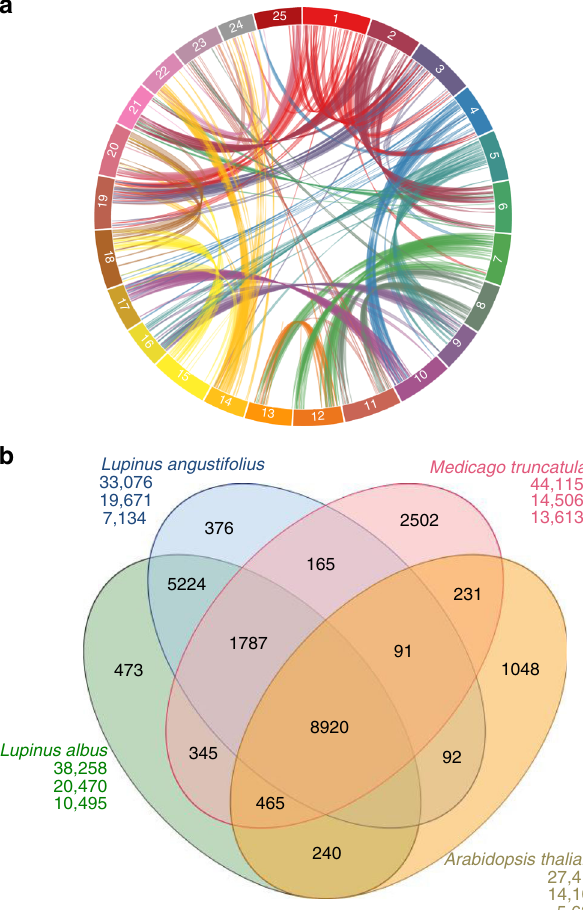
Fig. 4 Lupin genome intragenomic duplications and genomic synteny. a Syntenic regions inside white lupin genome. The colored lines link colinearity blocks that represent syntenic regions that are bigger than 50 kb. b OrthoMCL clustering of white lupin genes with those of L. angustifolius , M. truncatula and A. thaliana . Numbers in the sections of the diagram indicate the number of clusters (gene groups). The fi rst number below each species name is the total number of genes of the species, the second number is the number of genes in clusters and the third number is the number of genes that did not